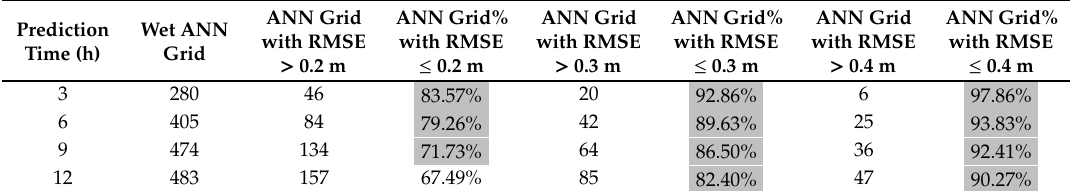
Note: highlighted in gray are the percentages larger than 70%.